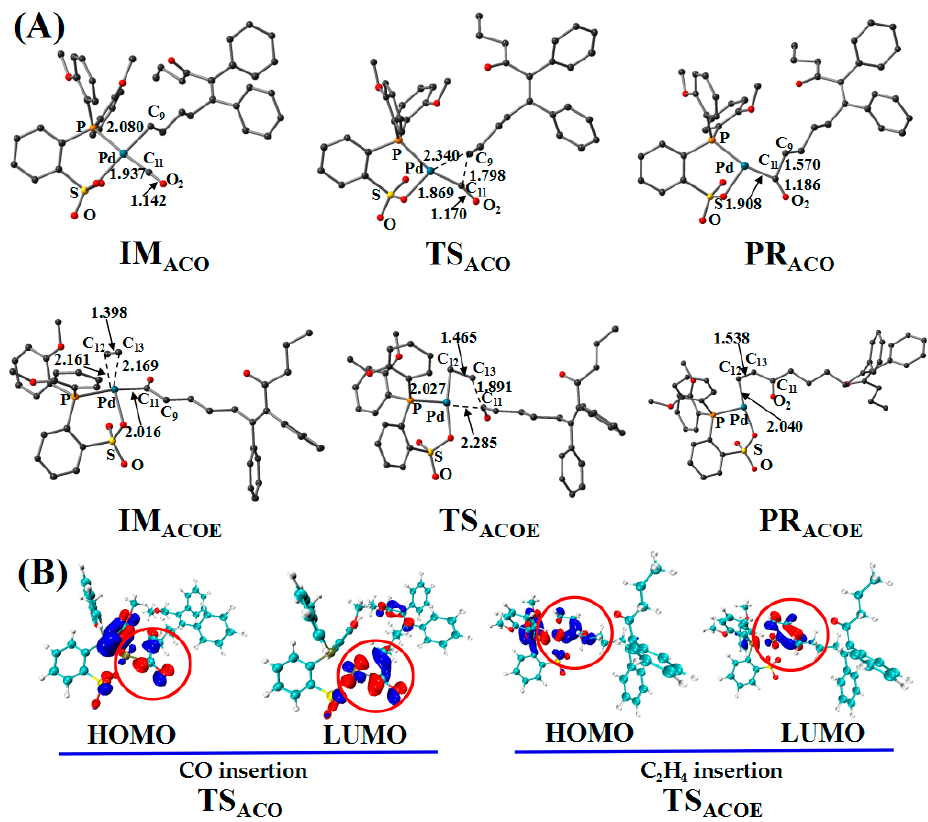
Figure 10. ( A ) Optimized structures in the reaction pathway for generation of UnitB shown in Figure 9, the key length is in angstroms. For clarity, the hydrogen atom is omitted. ( B ) The frontier orbital (HOMO and LUMO) of the transition states. Table 4. The Wiberg bond indices (WBIs) and natural charges (Q NBO ) for some key bonds and atoms of the reaction pathway for generation of UnitB. WBI Q NBO ( e